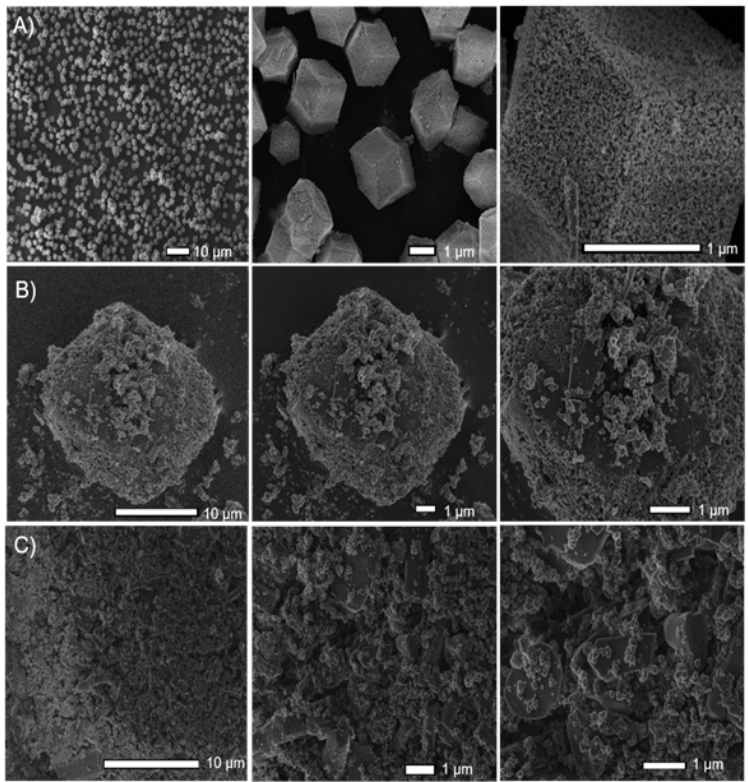
Figure 10. SEM-FEG images for RCA: ( A ) before CCM incorporation; ( B ) CCM@RCA-1D; and ( C ) CCM@RCA-3D.